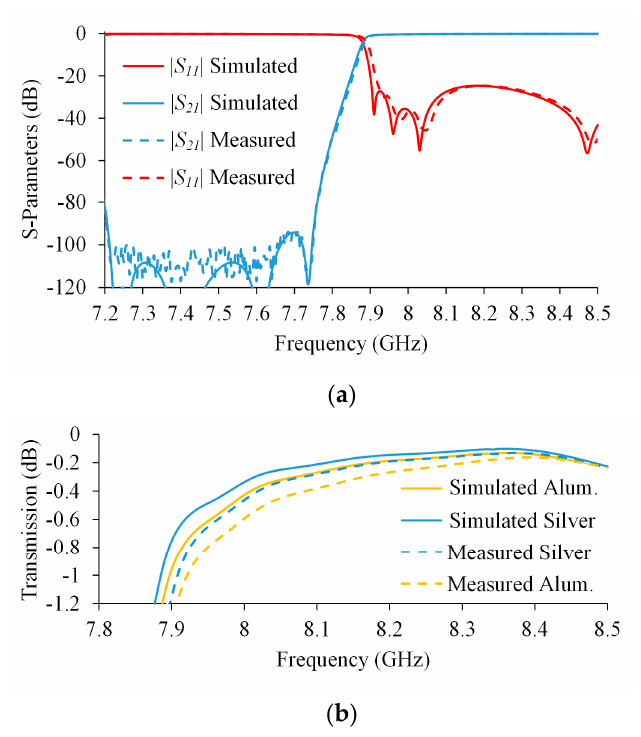
Figure 14. Comparison between measured and simulated results of the Tx filter. ( a ) Full scale reflection and transmission for the silver-plated version, ( b ) zoomed transmission in the band of interest.